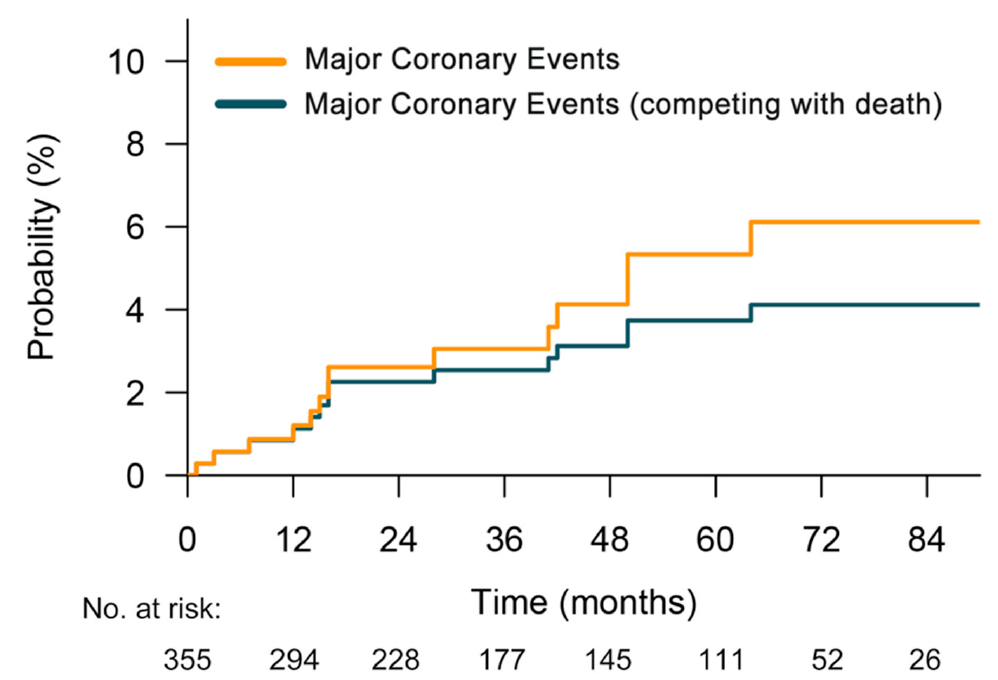
Figure 1. Cumulative incidence plot of major coronary events after chemoradiation (yellow) and major coronary events adjusted for the competing risk of death